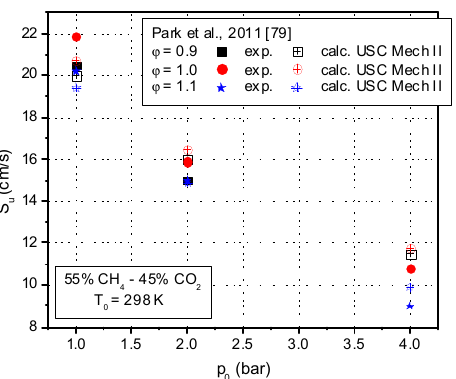
Figure 8. Initial pressure influence on laminar burning velocity, at various equivalence ratios and 298 K.